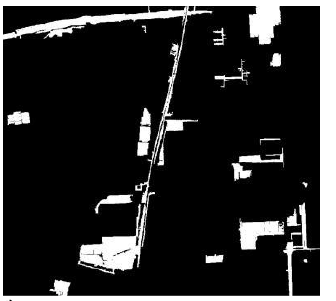
Figure 8. Results of Each Detection Method